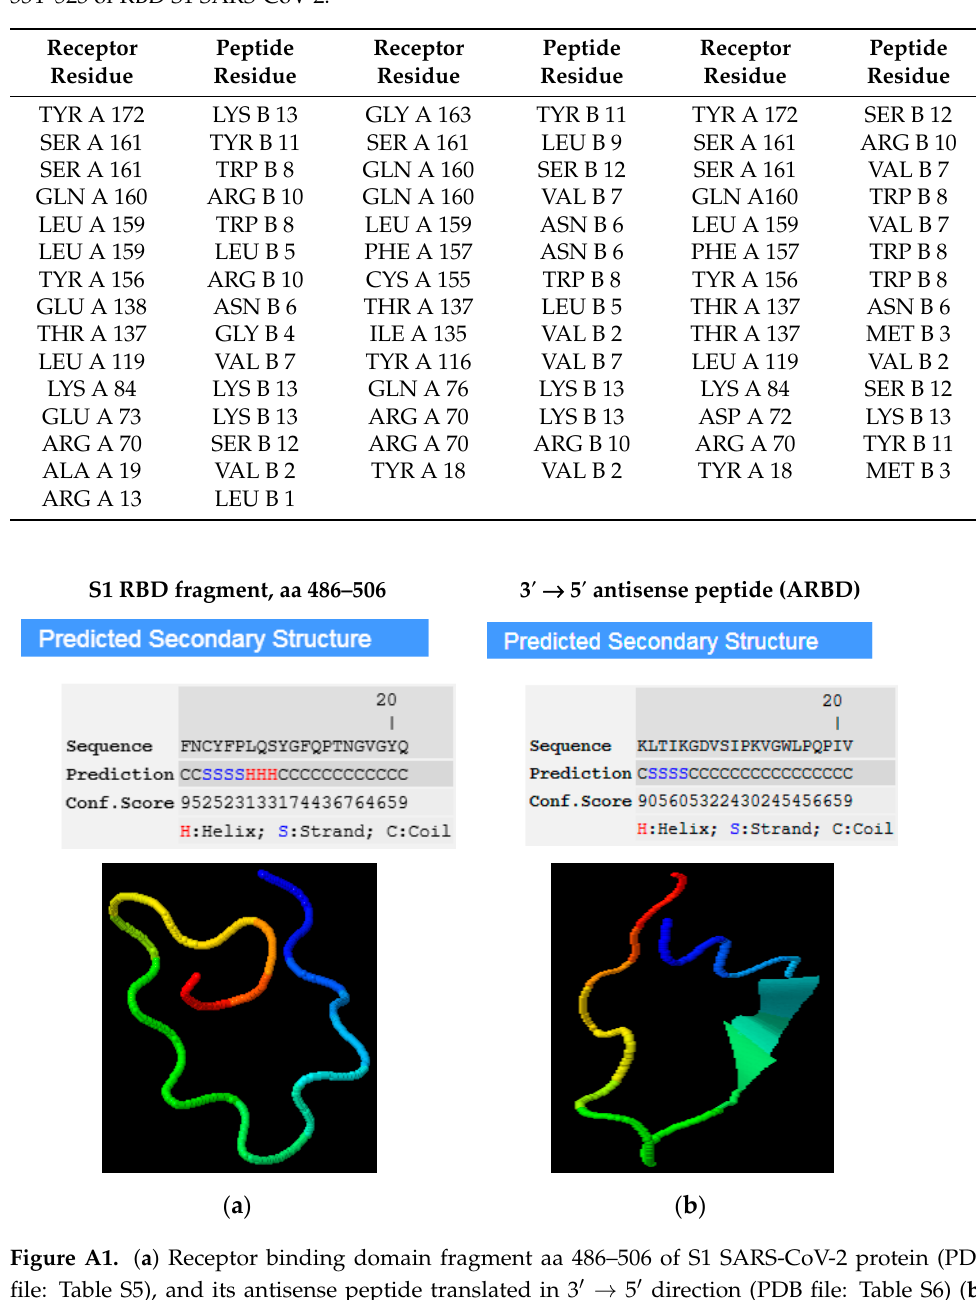
Table A4. Pairs of peptide/receptor residuals closer than 4.5 Å in the selected complex using CABS- dock method [28]. Peptide sequence was LVMGLNVWLRYSK [29] and receptor was region aa